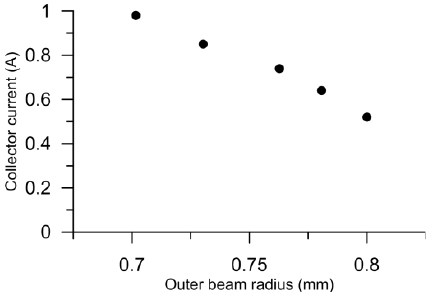
Fig. 3. Measured collector current vs. outer beam